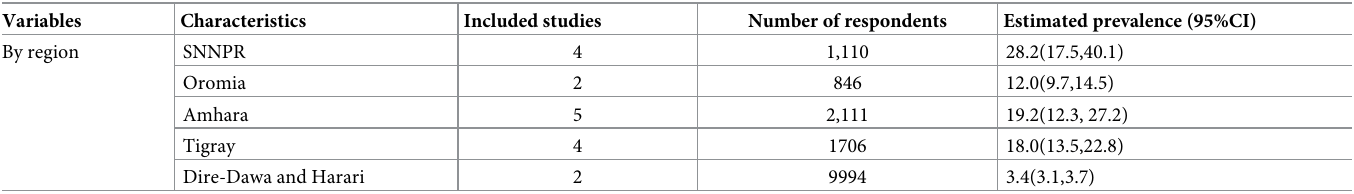
Table 3. Subgroup analysis of pooled prevalence of birth asphyxia in Ethiopia,